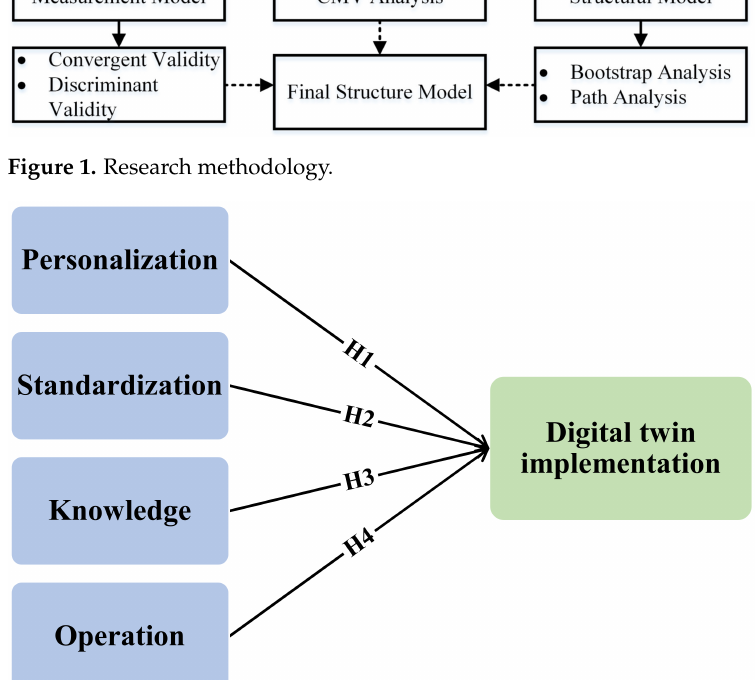
Figure 2. Hypothesized